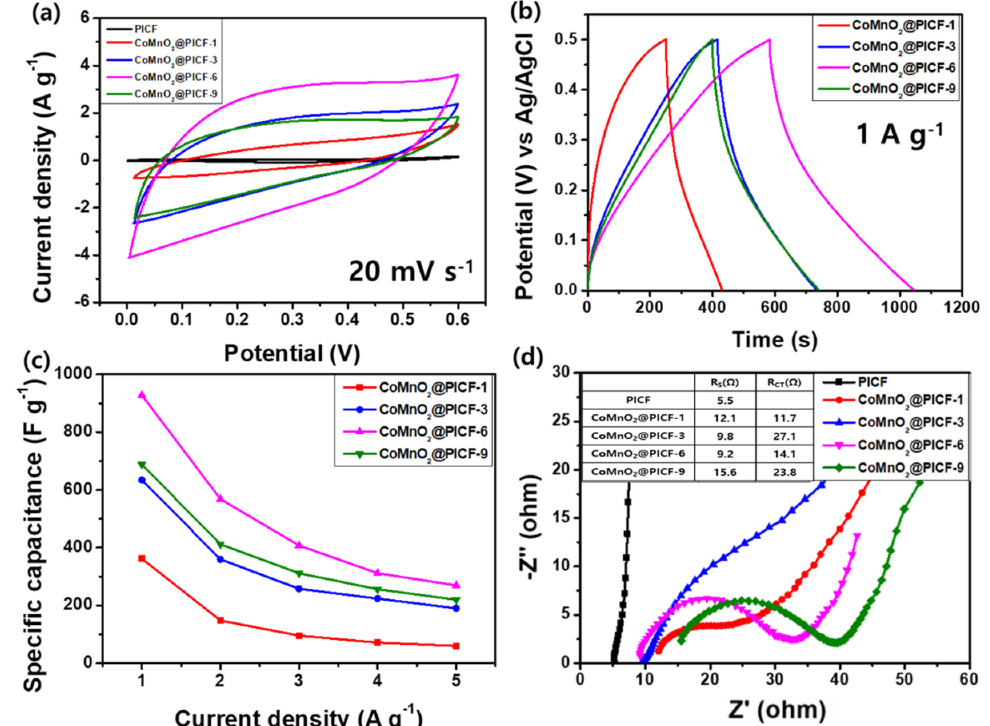
Figure 2. Cyclic voltammetry (CV) curves ( a ), galvanostatic charge–discharge (GCD) curves ( b ), relationship between capacitance and current density ( c ), and electrochemical impedance spectroscopy (EIS) curves ( d ) of pure PICFs, CoMnO 2 @PICF-1, CoMnO 2 @PICF-3, CoMnO 2